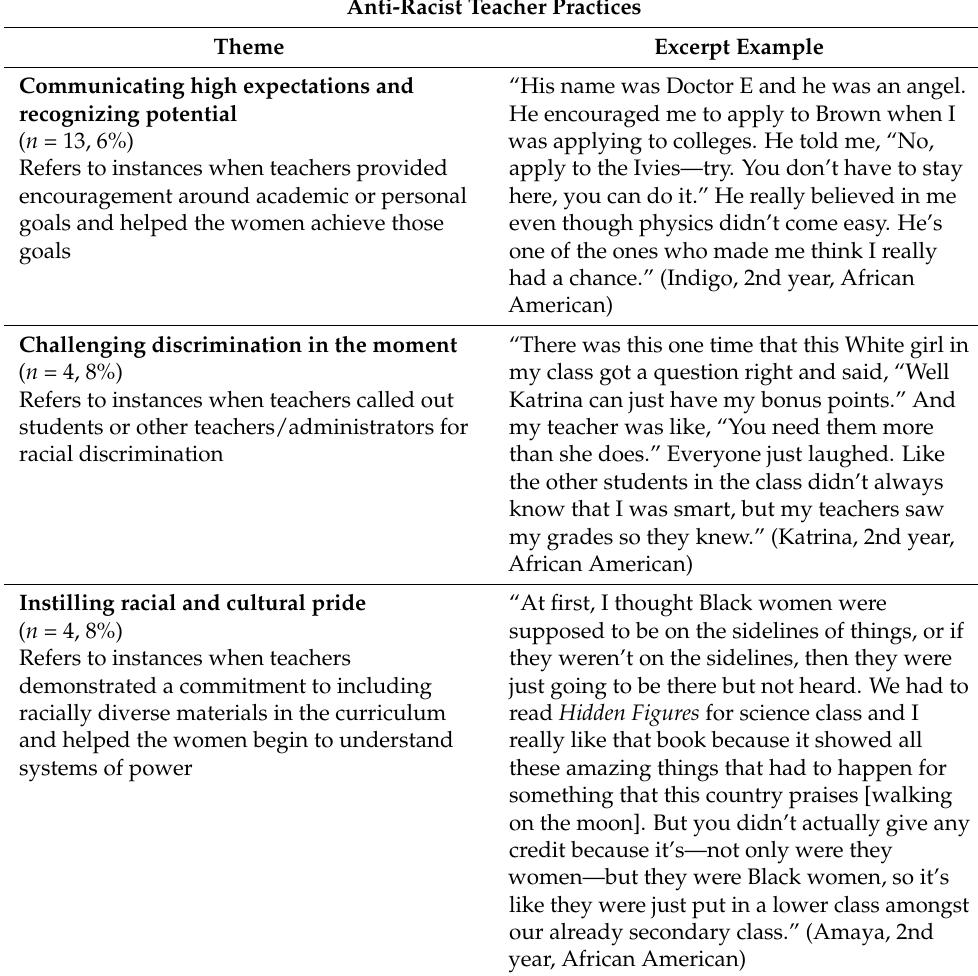
Table 3. Summary of anti-racist teacher